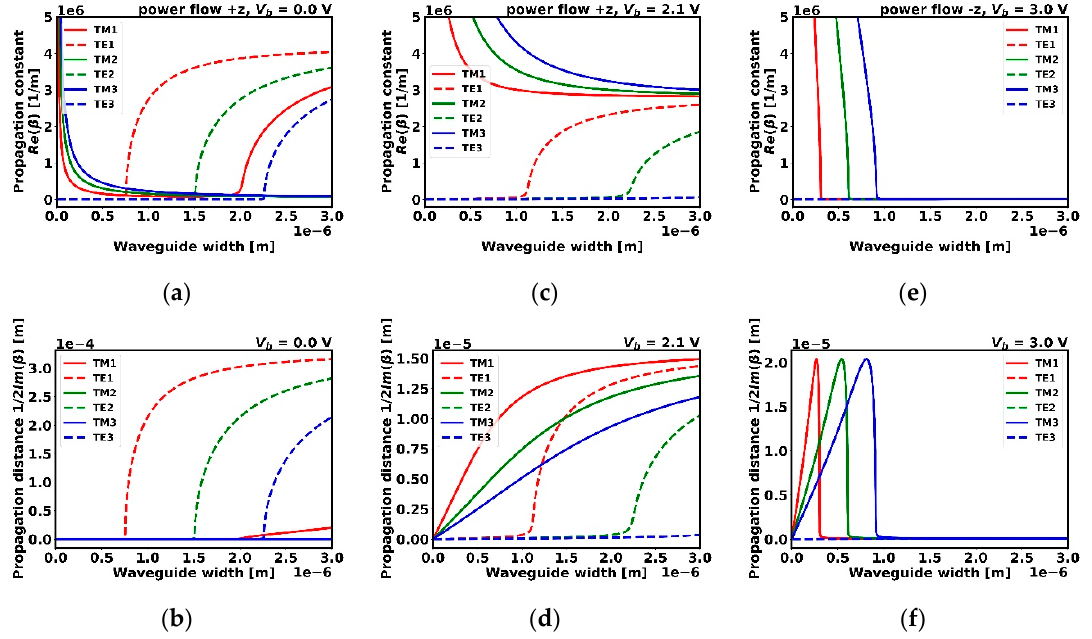
Figure 6. Propagation constant for configuration B at 1.55 µm in various dispersion regions, dependent on the voltage bias V b applied: ( a , b ) positive elliptic (0 V), ( c , d ) Type I HMM (2.1 V), and ( e , f ) Type II HMM (3 V). Power flow direction is indicated in each plot.